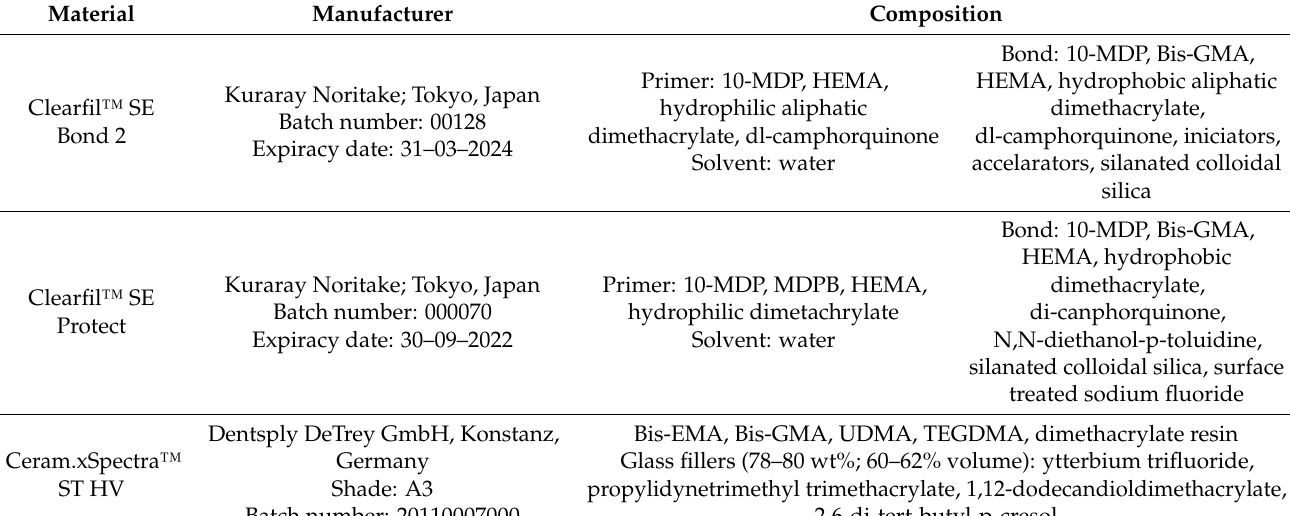
Table 1. List of restorative materials and their chemical composition according to information derived from the manufacturers. Material Manufacturer Composition